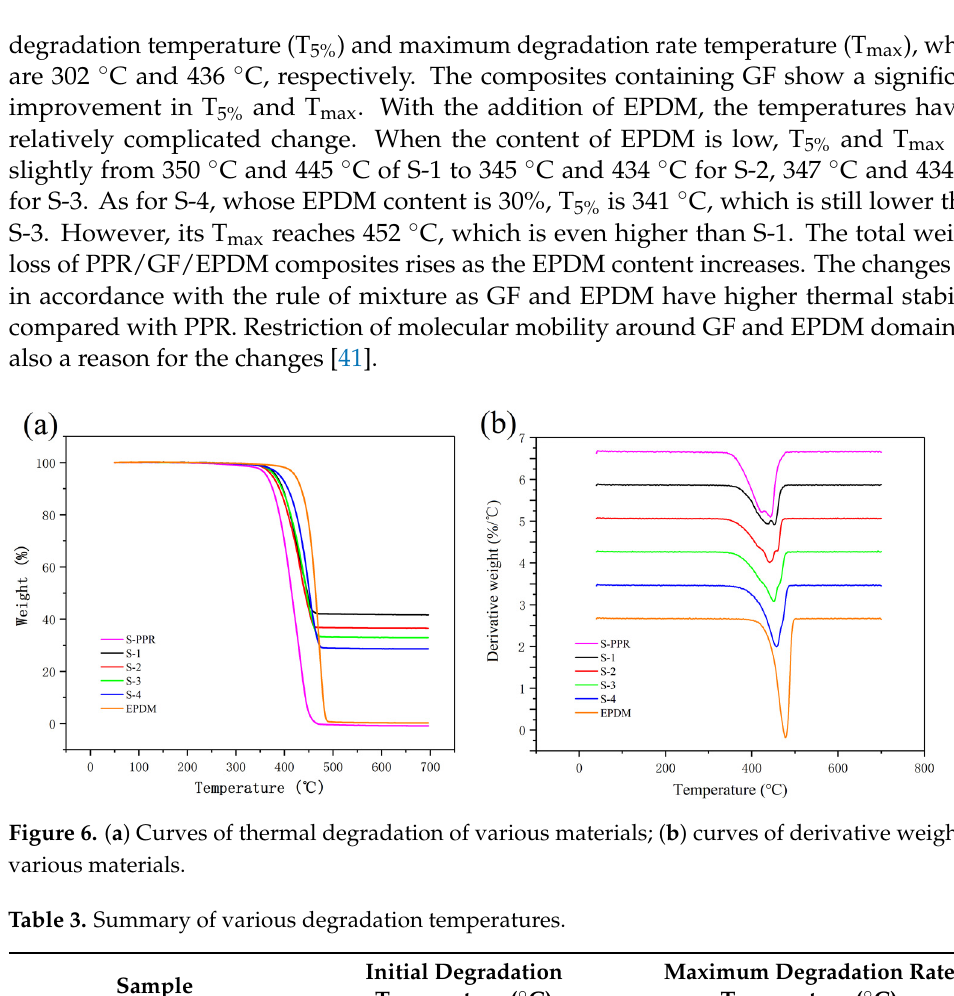
Table 3. Summary of various degradation temperatures.